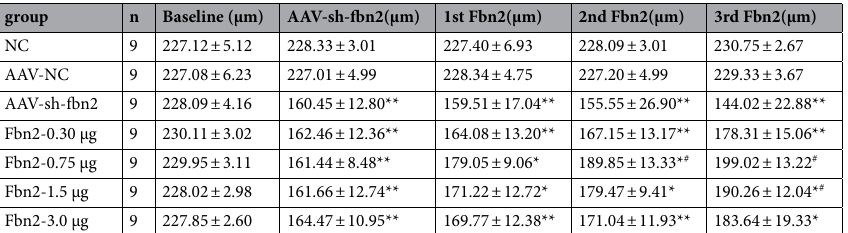
Table 2. Retina thickness measurements (mean ± standard deviation). NC group, Animals without intervention. AAV-NC group, Animals with an intravitreal injection of AAV empty vector and without any further treatment. AAV-sh-fbn2 group, Animals with an intravitreal injection of AAV-sh-fbn2 and without any further treatment. Fbn2-0.30 μg group, Animals with an intravitreal injection of AAV-sh-fbn2, followed by an intravitreal injection of fbn2 recombinant protein in a dose of 0.30 μg. Fbn2-0.75 μg group, Animals with an intravitreal injection of AAV-sh-fbn2, followed by an intravitreal injection of fbn2 recombinant protein in a dose of 0.75 μg. Fbn2-1.5 μg group, Animals with an intravitreal injection of AAV-sh-fbn2, followed by an intravitreal injection of fbn2 recombinant protein in a dose of 1.50 μg. Fbn2-3.0 μg group, Animals with an intravitreal injection of AAV-sh-fbn2, followed by an intravitreal injection of fbn2 recombinant protein in a dose of 3.00 μg. * P < 0.05 compared with the AAV-NC group; ** P < 0.001 compared with the AAV-NC group; # P < 0.05 compared with the AAV-sh-fbn2 group; ## P < 0.001 compared with the AAV-sh-fbn2